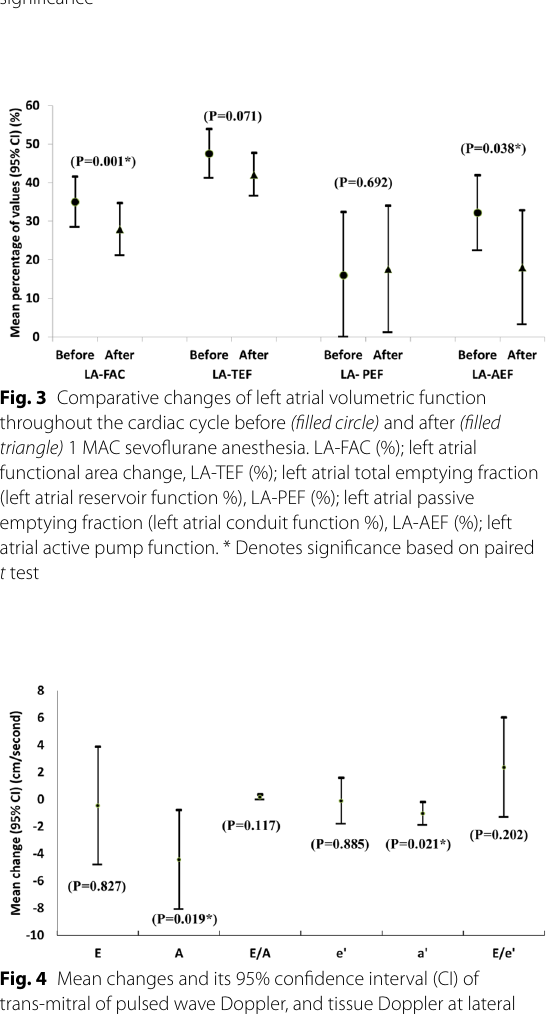
Fig. 2 Mean changes and its 95% confidence interval (CI) of the maximum, minimum and pre-P wave left atrial volumes before and after 1 MAC sevoflurane anesthesia. LAV; left atrial volume. * Denotes significance